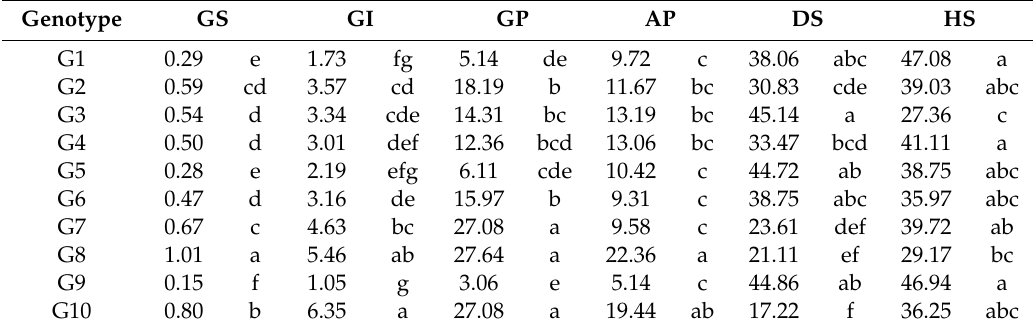
Table 5. Comparison of Tukey’s means ( p > 0.05) for genotypes in physiological variables. Genotype GS